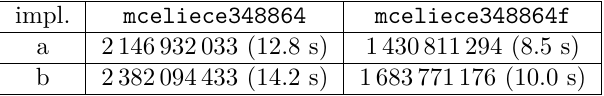
Table 3: Average (of 100 runs) cycle counts and the corresponding time in seconds for key generation of mceliece348864* .